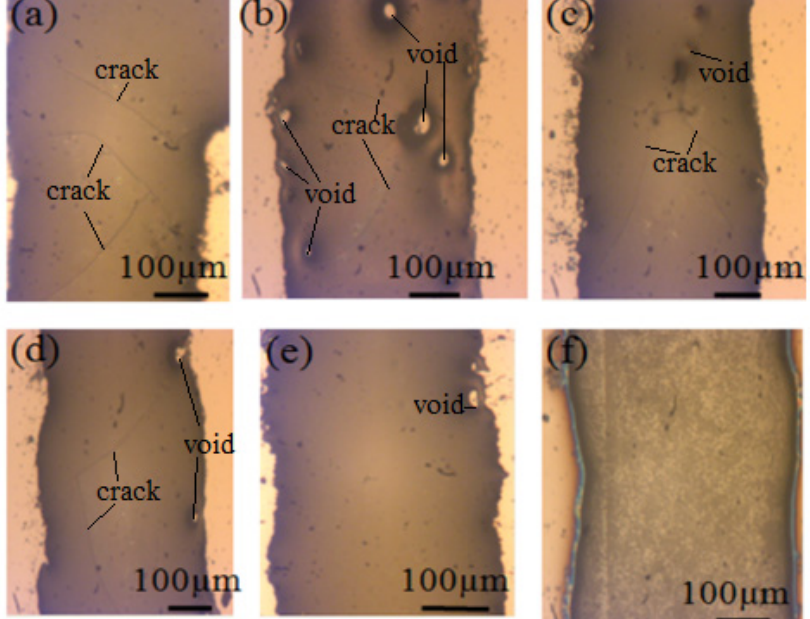
Figure 1. CCD images of the glass frit surface of different Cases after pre-sintering: ( a , b ) Annealing in air and under vacuum at 400 °C for 60 min, respectively; ( c ) Annealing in air at 450 °C for 30 min and annealing under vacuum at 450 °C for 30 min; ( d , e ) Annealing in air at 450 °C for 30 min and annealing under vacuum at 450 °C for 30 min and annealing in air at 450 °C for 30 min and for 60 min, respectively; ( f ) Annealing in air at 450 °C for 30 min and annealing under vacuum at 450 °C for 30 min and annealing in air at 500 °C for 60 min.